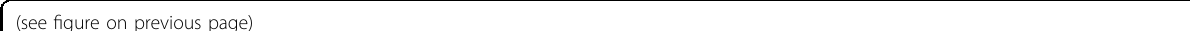
Fig. 1 PALB2 CN loss in AML and its prognostic relevance. A Graphical representation of PALB2 mRNA and protein functional domains. The coiled-coil domain (red) is involved in the interaction with BRCA1; the chromatin-association motif (ChAM, blue) is required for chromatin association and it mediates nucleosome association; the WD40 domain (green) is responsible for the interaction with RAD51, BRCA2, and POLH. Gray bars represent CN loss detected in AML patients. B Frequency (%) and the signi fi cance of genomic CN changes between PALB2 loss and wild-type patients. Blue indicates CN gains and red indicates CN loss. Results are summarized for a group of patients ( PALB2 loss vs. PALB2 wild-type). C Kaplan – Meier curve of PALB2 loss (blue) vs. PALB2 wild-type (green) AML. D Forest plot for the multivariable Cox regression analysis. yrs years, HR hazard ratio, CI con fi dence interval.